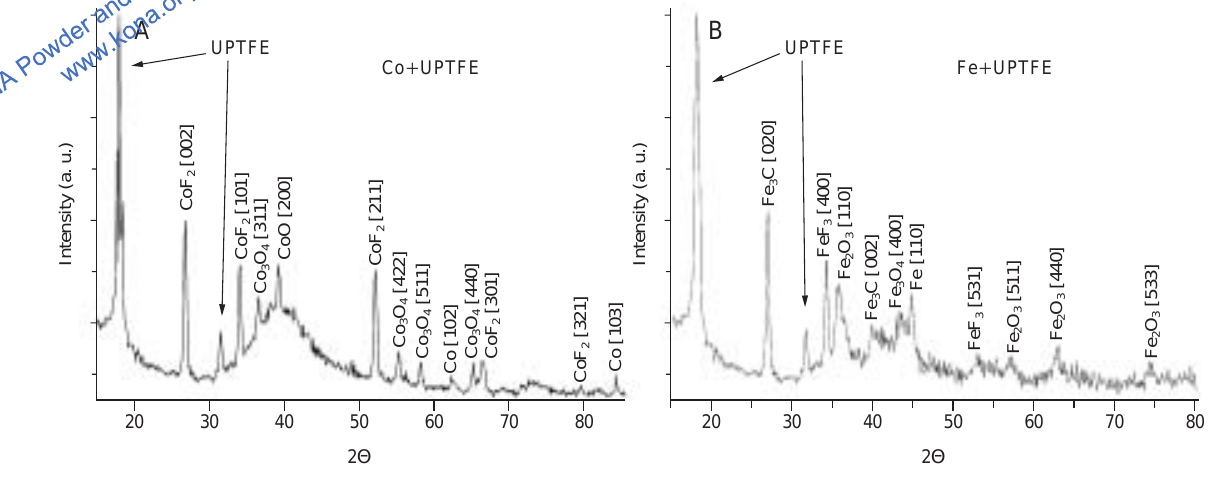
Fig. 5 Diffraction patterns for composite materials Co (cid:5) UPTFE (a) and Fe (cid:5) UPTFE